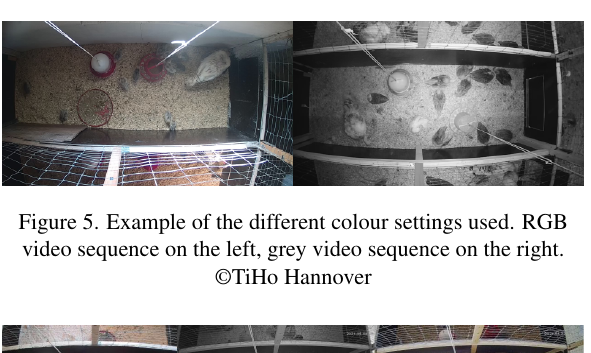
Table 1. Description of our novel dataset. ID: the number indicates the ID of a video sequence, while the letters denote that a sequence has been split. For example, the subsets 1a and 1b are both part of video sequence 1, where 1a contains frames 0 to 999 and 1b the frames 1000 to 1999. #Frames: number of frames in the video sequence. Size: the growth status of the chicks in the video sequence. Colour setting: colour settings used while recording (RGB or grey). Use: indicate whether a video sequence is used for training, validation or testing.